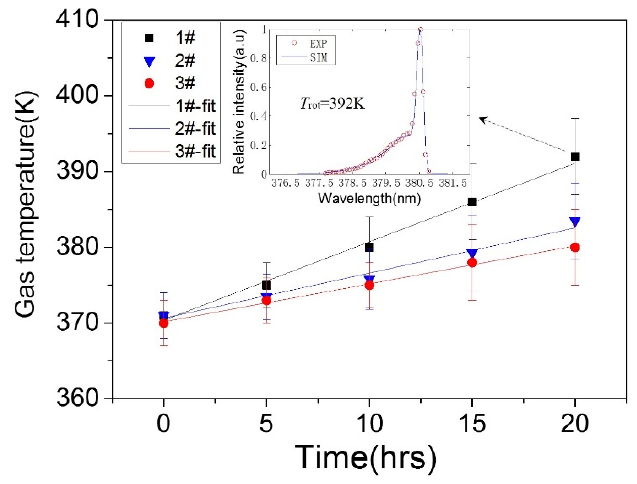
Figure 10. Effects of plasma discharge aging on the gas temperatures of the three devices.